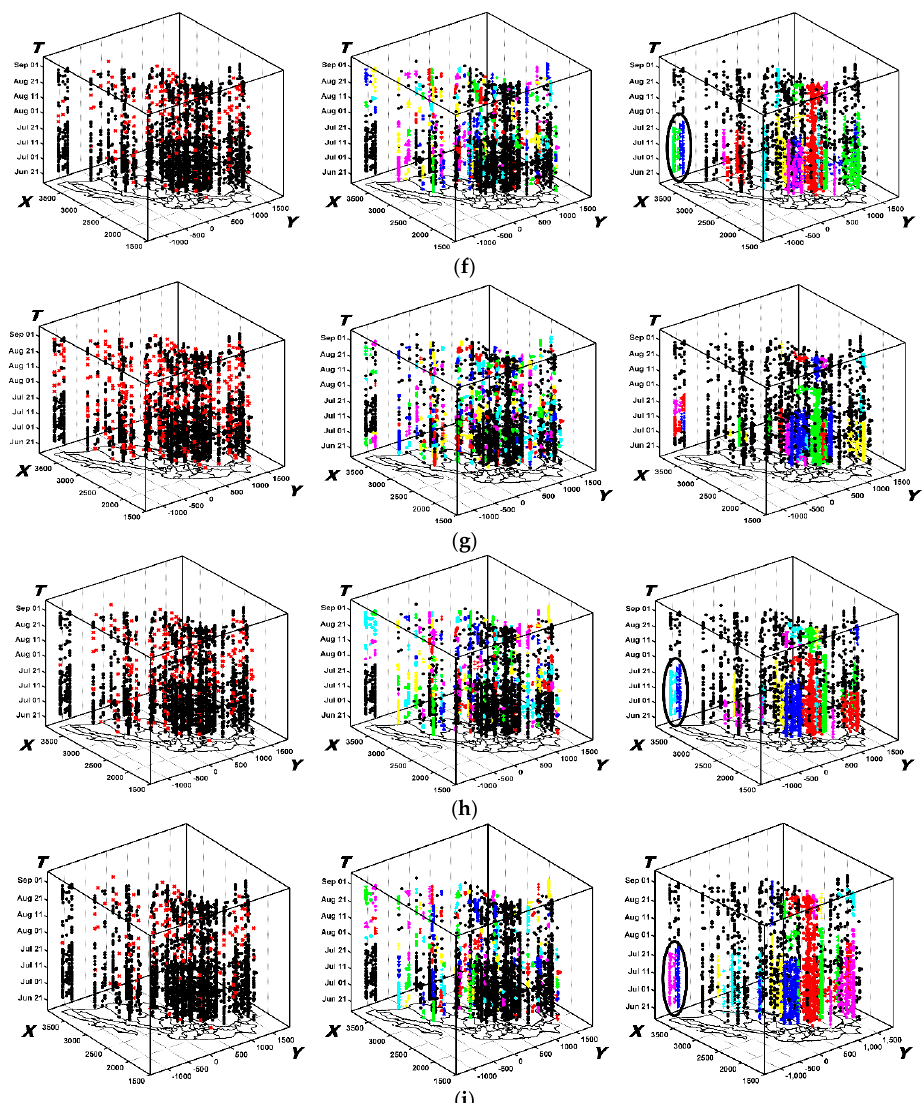
Figure 11. The evolving spatio-temporal patterns of STTE discovered by the proposed method. ( a ) δ = 1, ε = 1; ( b ) δ = 1, ε = 2; ( c ) δ = 1, ε = 3; ( d ) δ = 2, ε = 1; ( e ) δ = 2, ε = 2; ( f ) δ = 2, ε = 3; ( g ) δ = 3, ε = 1; ( h ) δ = 3, ε = 2; ( i ) δ = 3, ε = 3.